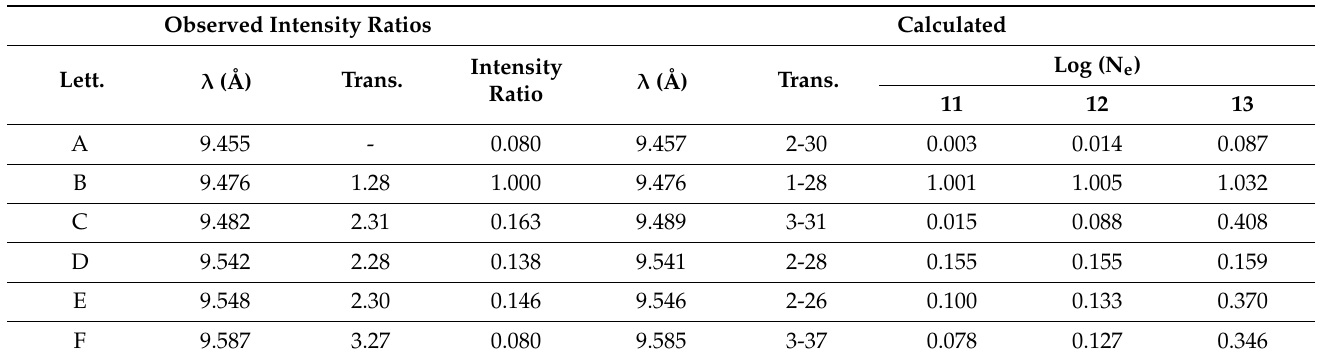
Table 8. Observed and theoretical wavelengths and intensities for Fe